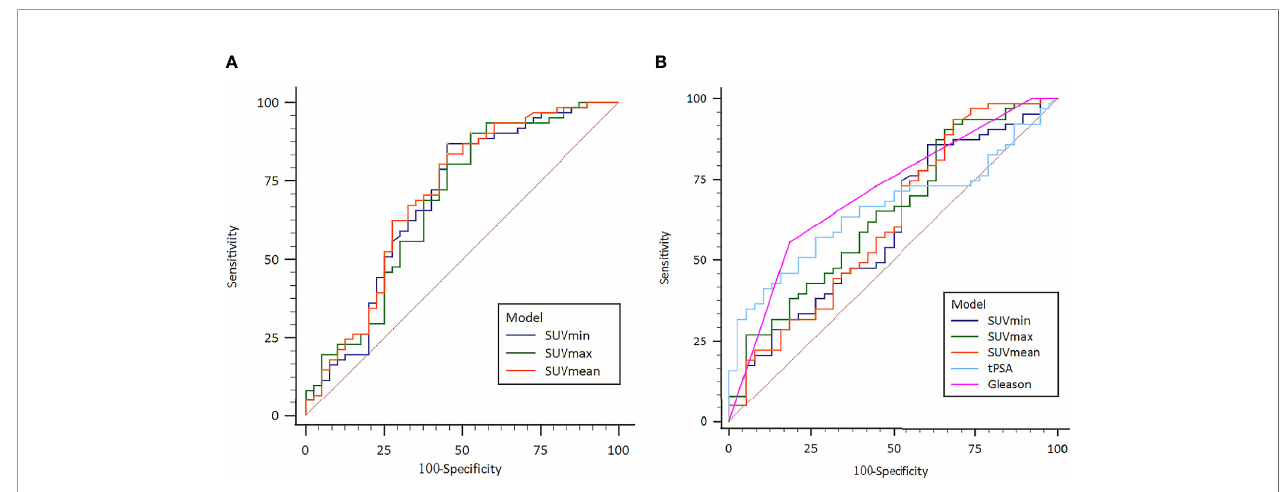
FIGURE 3 | (A) Receiver operating characteristic (ROC) curve of the 18 F-PSMA-1007 PET/CT indexes for prostate cancer risk strati fi cation; (B) Receiver operating characteristic (ROC) curve of the 18 F- PSMA-1007 PET/CT prostate cancer metastasis risk prediction.